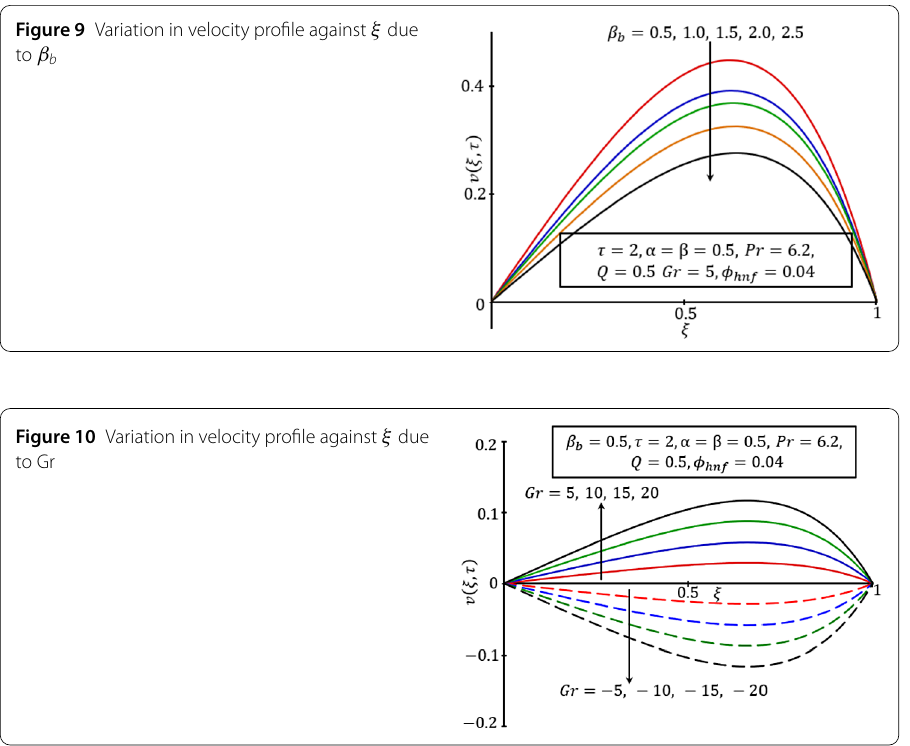
Figure 9 Variation in velocity profile against ξ due to β b